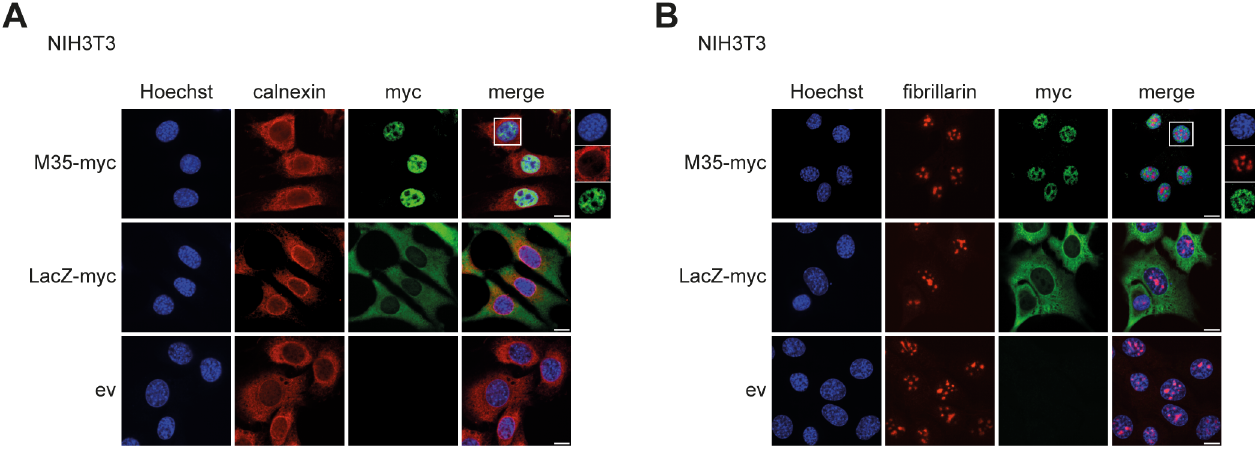
Fig 3. M35 is localized to the nucleus, but excluded from nucleoli. NIH3T3 fibroblasts stably expressingLacZ-myc or M35-myc or empty vector (pQCXIH) were fixed for immunolabeling with a mouse anti-myc antibody and either a rabbit anti-calnexin (A) or rabbit anti-fibrillarin (B) antibody and imagedby confocalmicroscopy. Nuclei were stainedwith Hoechst. Scale bars represent 10 μ m.